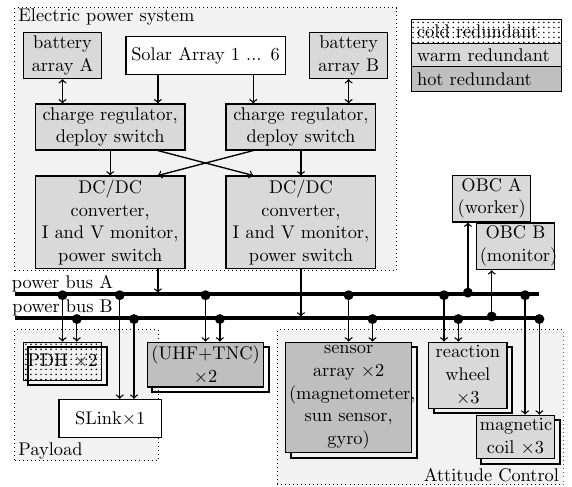
Figure 9. Redundancy and power distribution of space